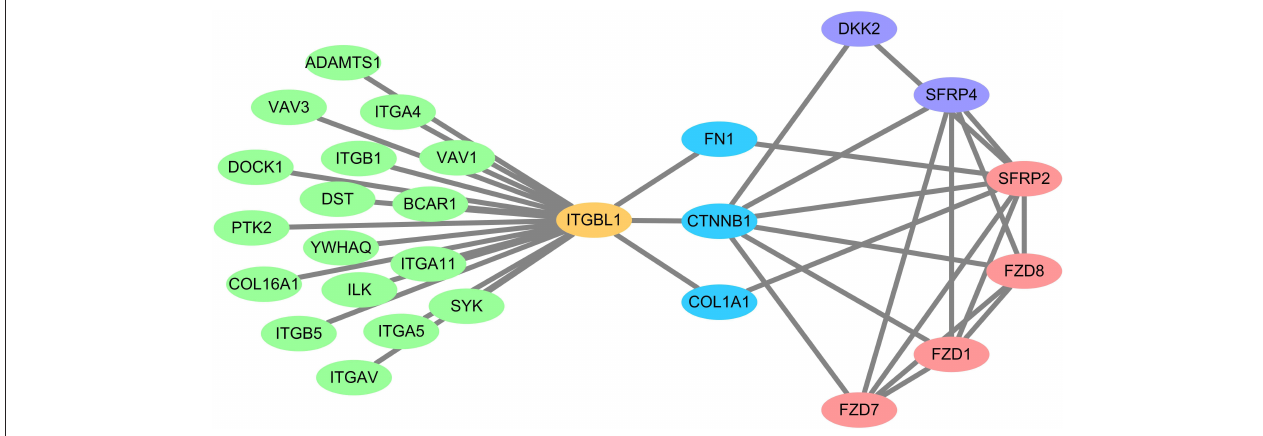
FIGURE 3 | Interaction network of ITGBL1 and extracellular Wnt signal. The red nodes (SFRP2, FZD1, FZD7, FZD8) were extracellular Wnt signals that were upregulated in the stroma. The purple nodes (SFRP4, DKK2) were extracellular Wnt signals that were upregulated in both the stroma and parenchyma. The blue nodes (FN1, CTNNB1, COL1A1) were all ITGBL1 binding proteins, and they also bound to extracellular Wnt signal. The green nodes were ITGBL1 binding proteins. The yellow node was the ITGBL1